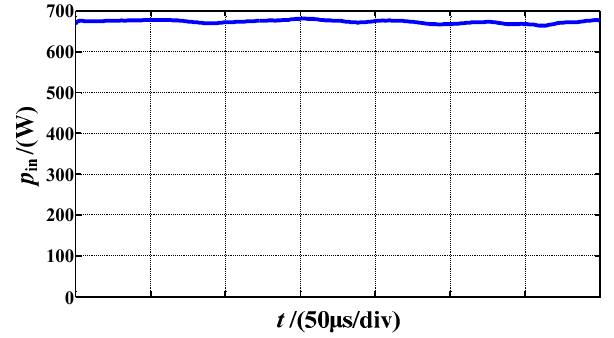
Figure 16. Voltage, current and power of supercapacitor.